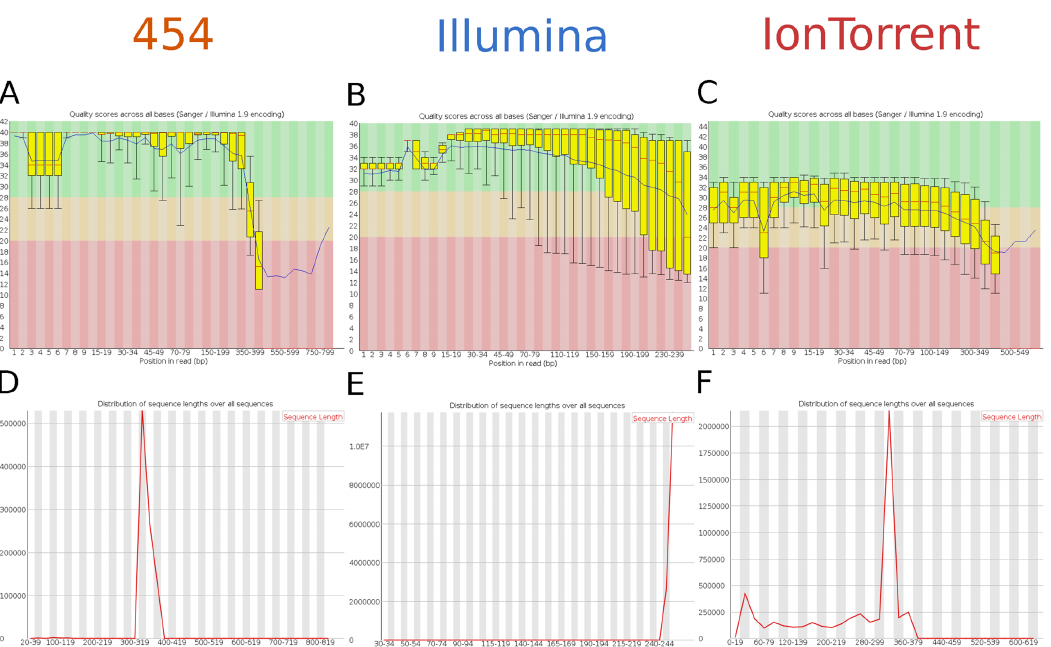
Fig 3. Platform comparison — base quality & read length quality assessment. Per base quality scores and read length of all three platforms are shown for 454 (A, D), Illumina (B, E), and IonTorrent (C, F) using FASTQC algorithm.